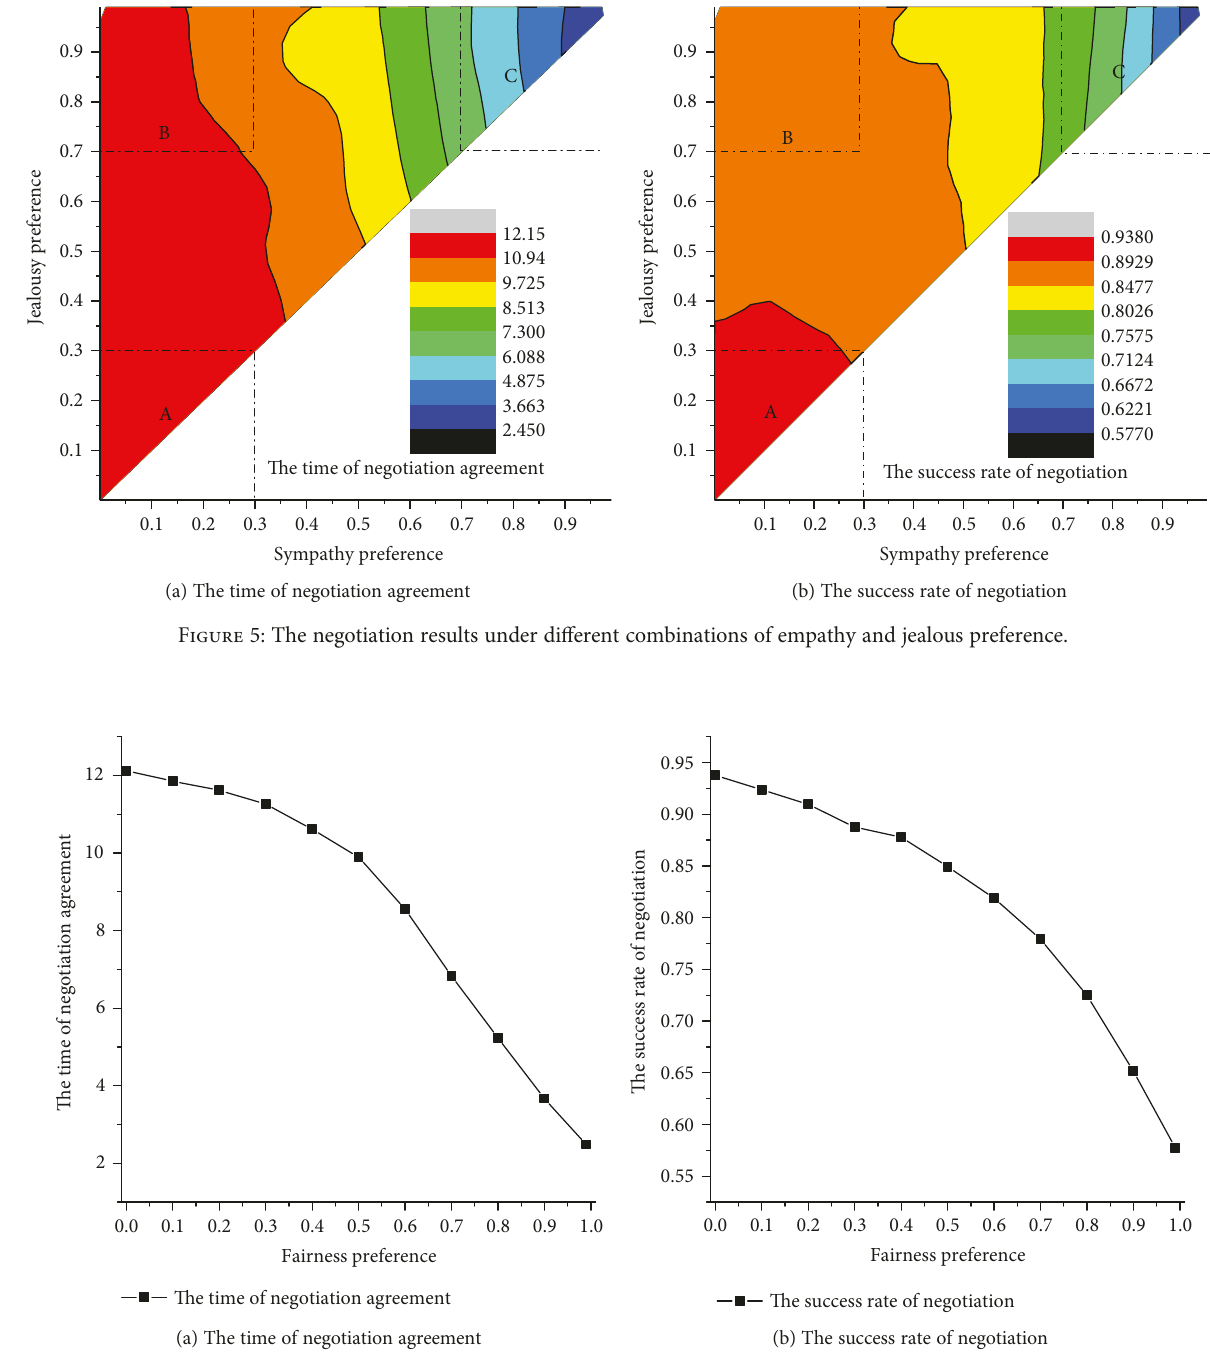
Figure 6: The negotiation results when empathy preference and jealous preference are the